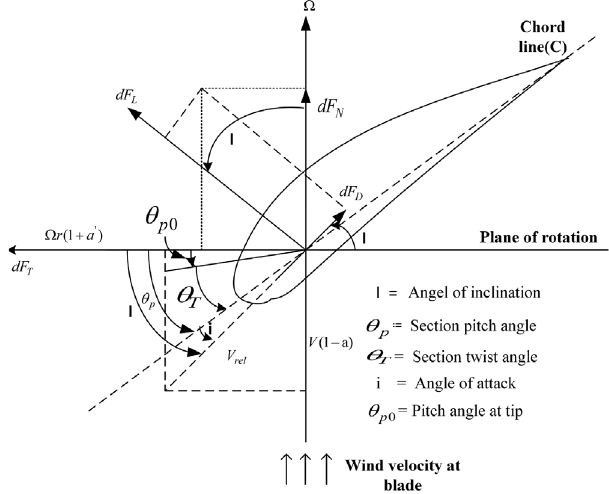
Figure 6. An airfoil of Horizontal Axis Wind Turbine showing its geometrical parameter and forces acting on